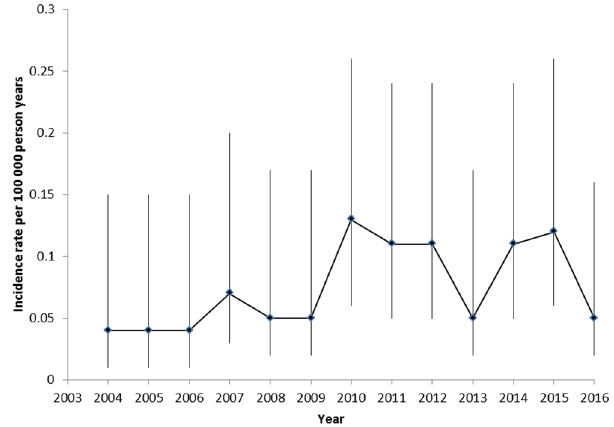
Figure 1. Incidence rate per 100 000 person years of M. marinum infection in Denmark with 95% confidence intervals. The population was defined as contributing to 1 person year per resident per year in the incidence rate